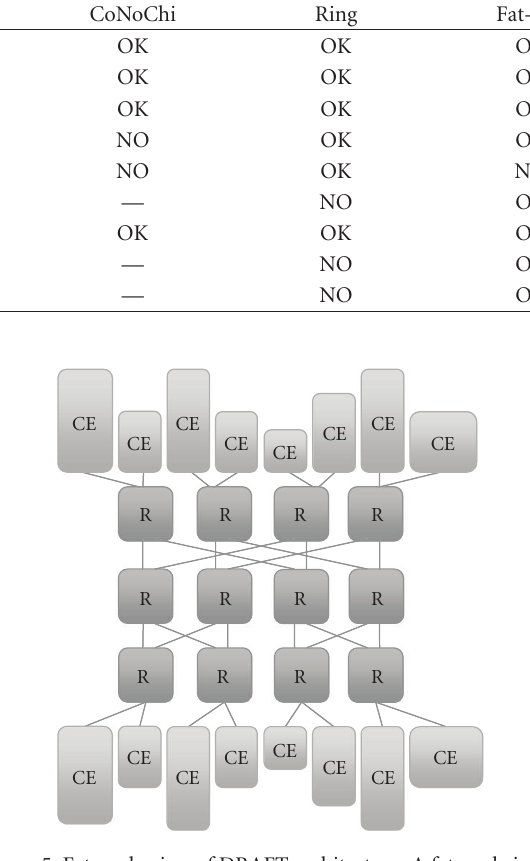
Figure 5: Fat-node view of DRAFT architecture. A fat-node is a set of unitary